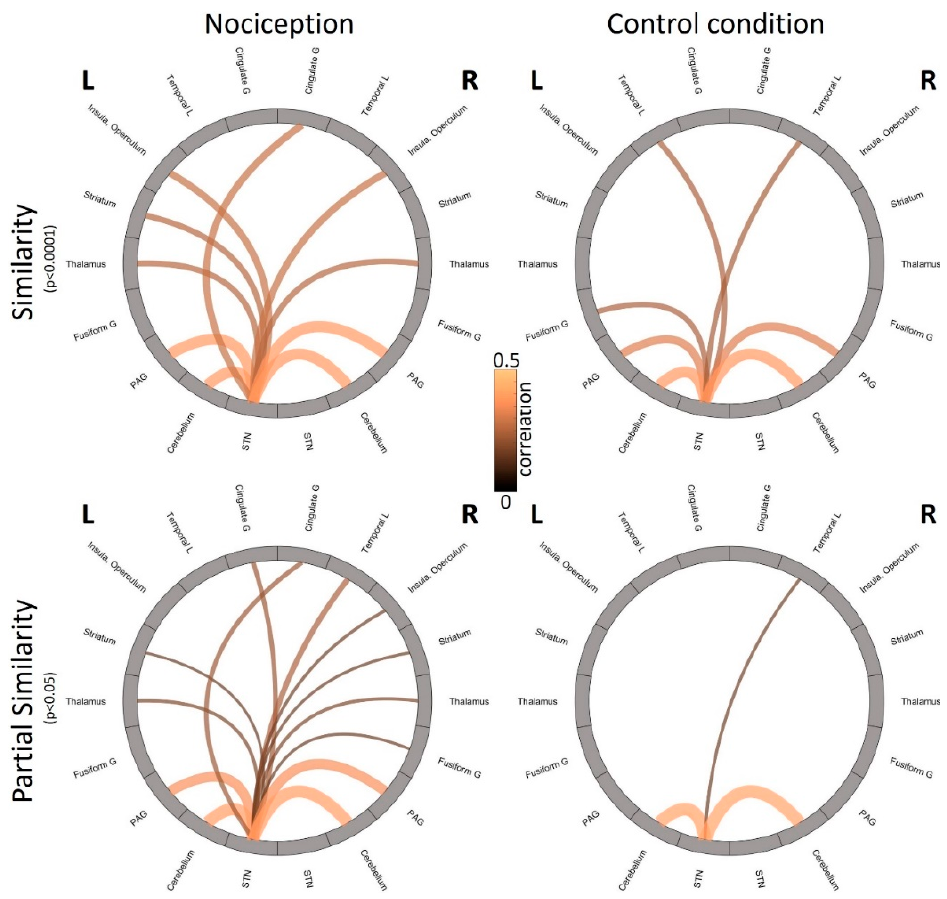
Figure 5. Plot of the interactions revealed by Similarity ( top ) and Partial Similarity ( bottom ) of the left STN to brainstem, cerebellum, midbrain, and cortical areas in the field of view during trigeminal nociception ( left ) and control condition (air puffs, right ). Each circle shows connections to the left hemisphere ( L ) on the left hand side of the circle and connections to the right hemisphere ( R ) on the right hand side the circle. Lines mark connections. Color and thickness of the lines signify the strength of the connection (correlation coefficient or partial correlation coefficient). G = Gyrus, L = Lobe. STN = Spinal trigeminal nucleus, PAG = Periaqueductal gray matter. Due to the restricted volume, no connectivity can be shown to other cortical areas.